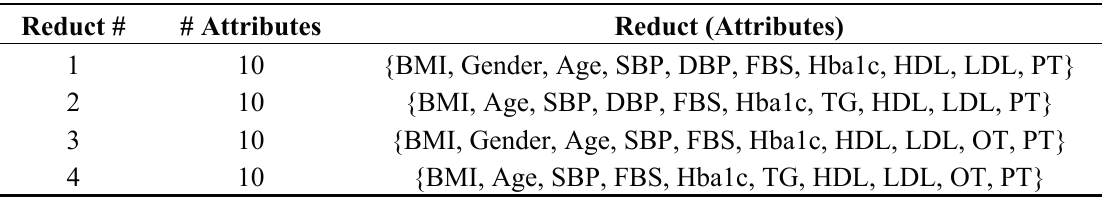
Table 7. List of all possible reducts for the Discretized Information System after applying Lattice Reduct Search